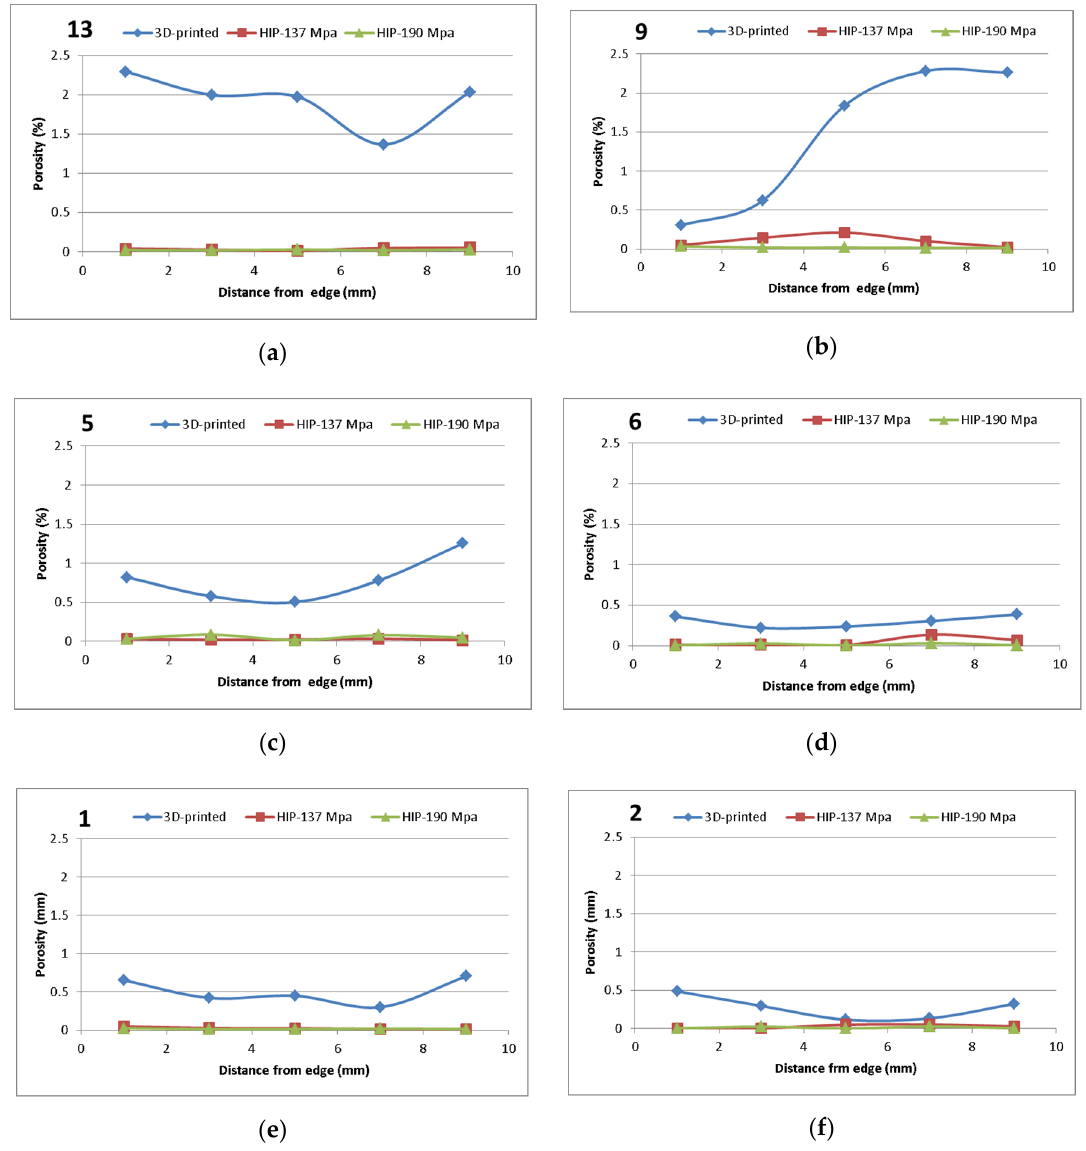
Figure 15. Porosity levels detected in samples after SLM, SLM + HIP_1 and SLM + HIP_2 by image analysis: ( a ) sample 13, ( b ) sample 9, ( c ) sample 5, ( d ) sample 6, ( e ) sample 1, and ( f ) sample